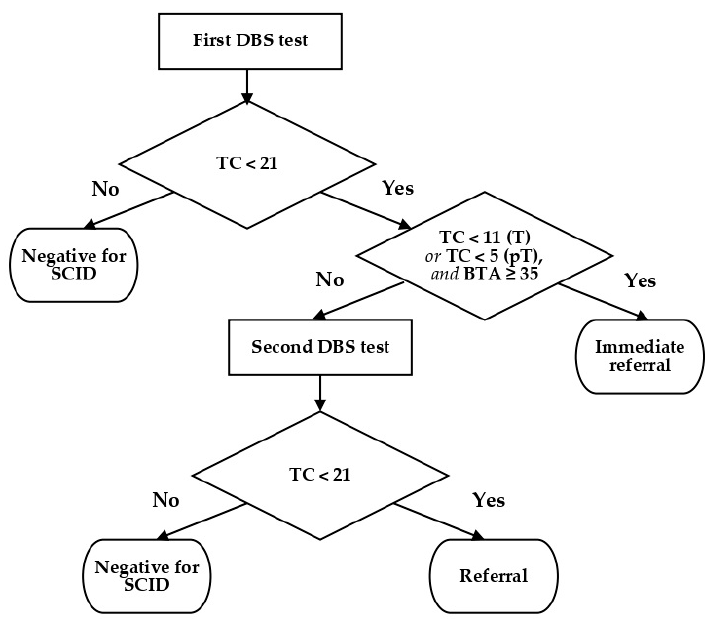
Figure 2. Decision-making algorithm. BTA = beta-actin count (copies/µL); DBS = dried blood spot; T = term; pT = preterm; TC = TREC count (copies/µL).